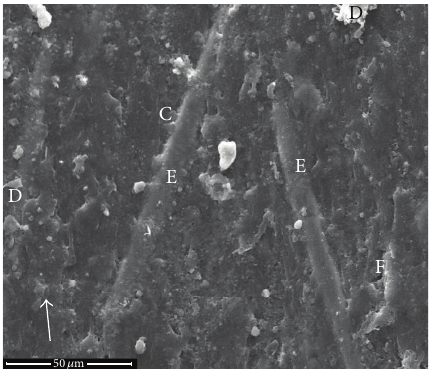
Figure 5: Scanning electron micrograph of TCE + PTFE with SGFs composite abraded with sand particle size of 212 𝜇 m, to a distance of 2185 m and at a load of 40N.